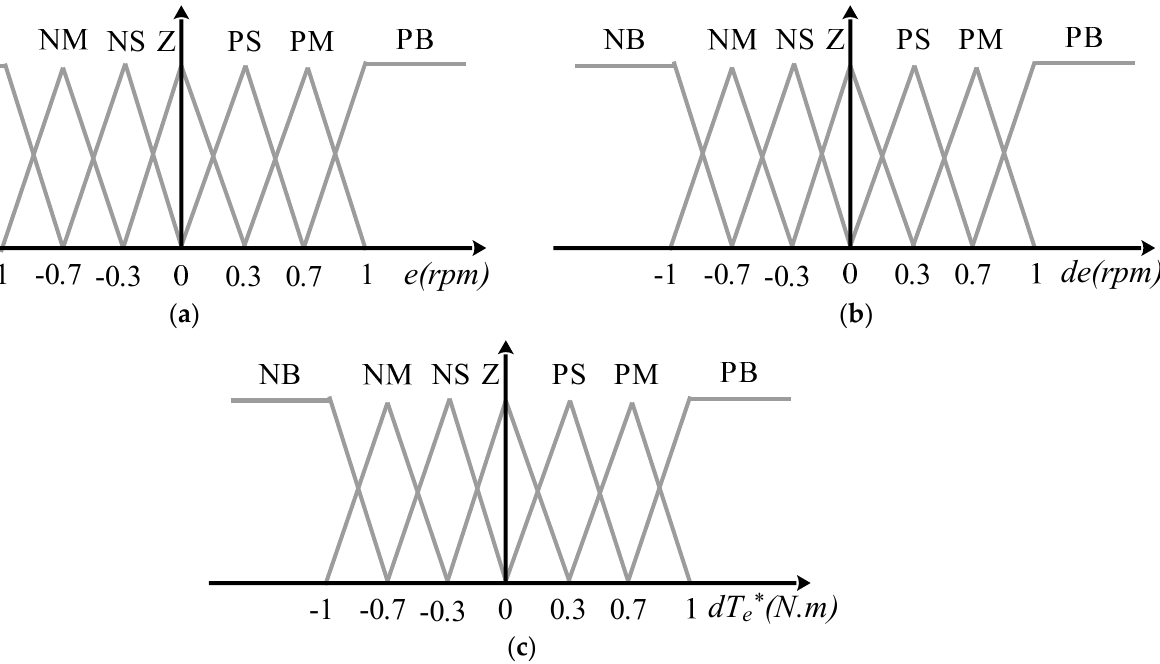
Figure 13. Membership functions for ( a ) speed error; ( b ) derivative speed error; ( c ) reference torque. Table 6. Rule base for speed